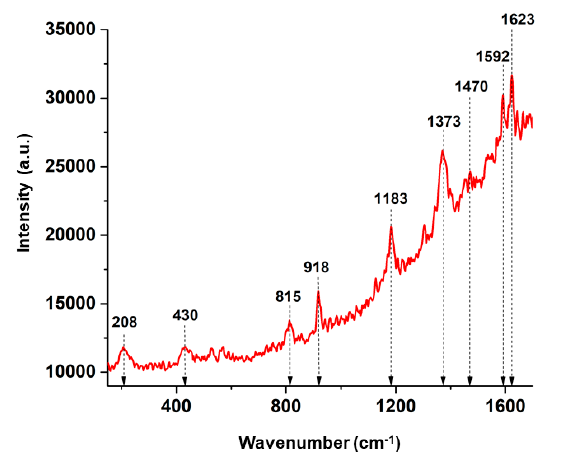
Figure 16. Raman spectrum of a 10 − 4 M crystal violet acquired under conditions foreign to the SiO 2 –HA–Ag substrate.